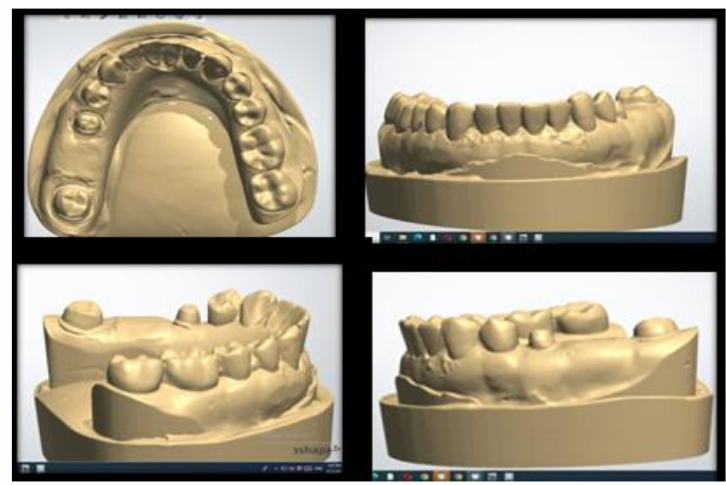
Figure 1. STL scan of the control reference